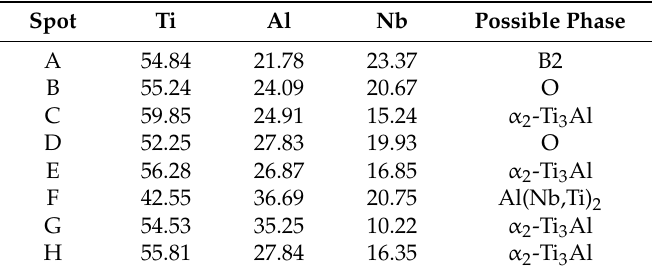
Figure 3. Typical interfacial microstructure of bonded joints at 970 ◦ C/60 min/5 MPa. ( a ) Backscattered electron (BSE) image and ( b ) high-magnified image. Table 1. Chemical compositions and possible phases of each spot marked in Figure 3b (atom %).